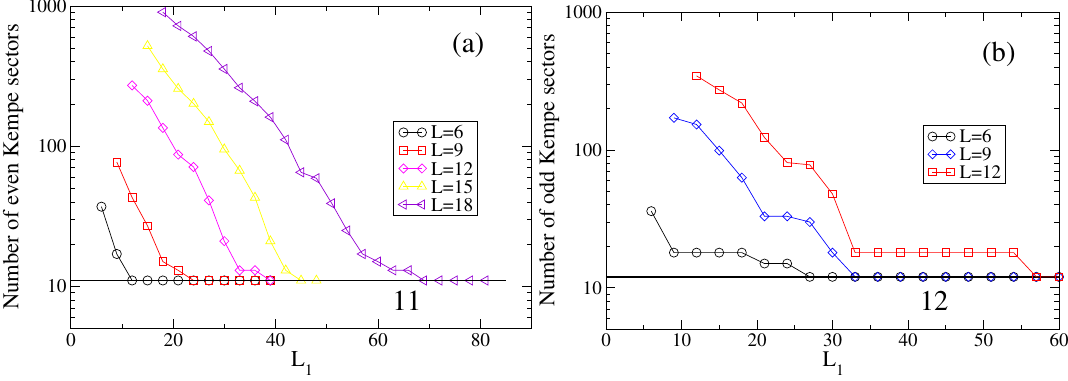
Figure 4: Stabilization of the number of even (a) and odd (b) sectors. The two numbers 11 and 12 give the number of stable sectors